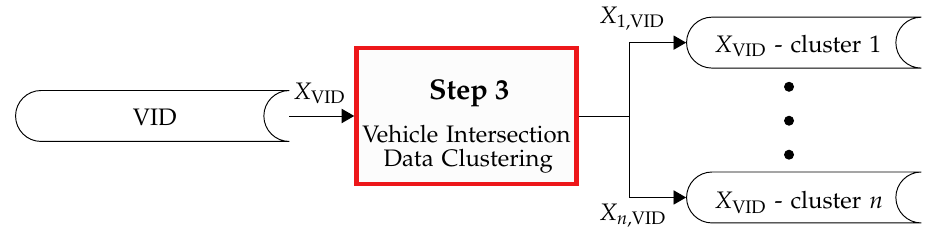
Figure 8. Overview of step 3 of the PROMOTING method: the VID clustering. The list X contains n routes of vehicles crossing the intersections and are clas- sified as defined in Section 3.2.2. It should be noted that only complete routes have been selected because they are the only type of routes that contain a full description of the intersection crossing from the entrance to the exit.